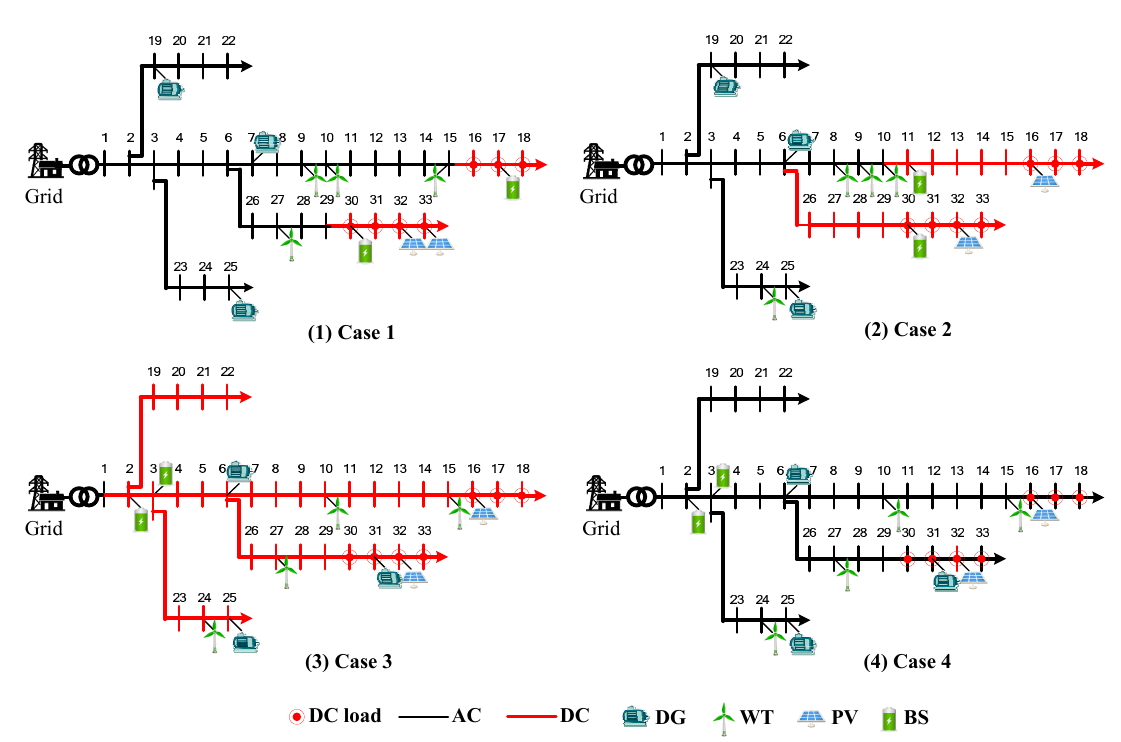
Figure 8. Placement of DERs in the four cases.